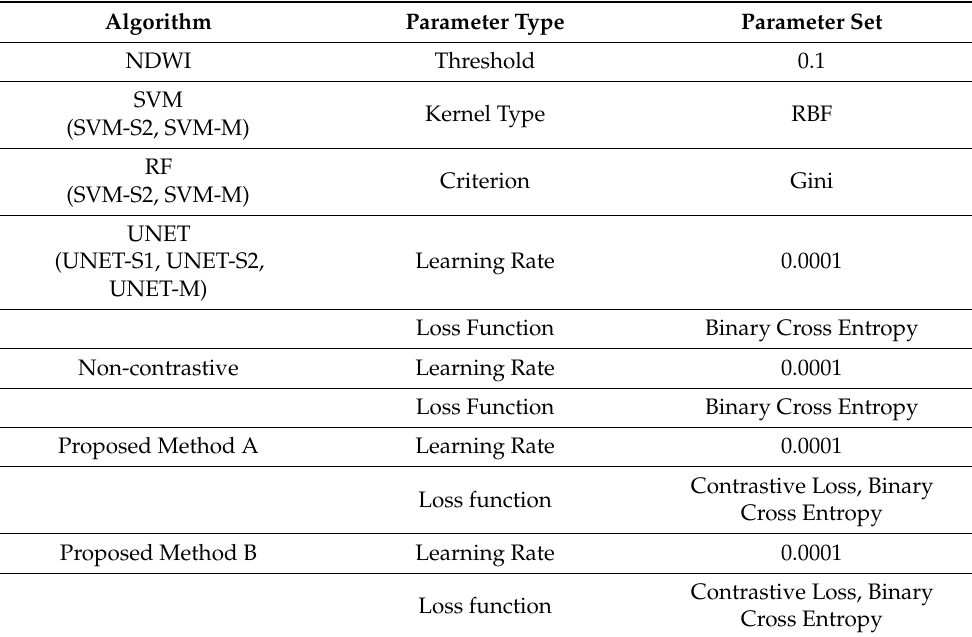
Table 3. Parameters for the baselines and proposed